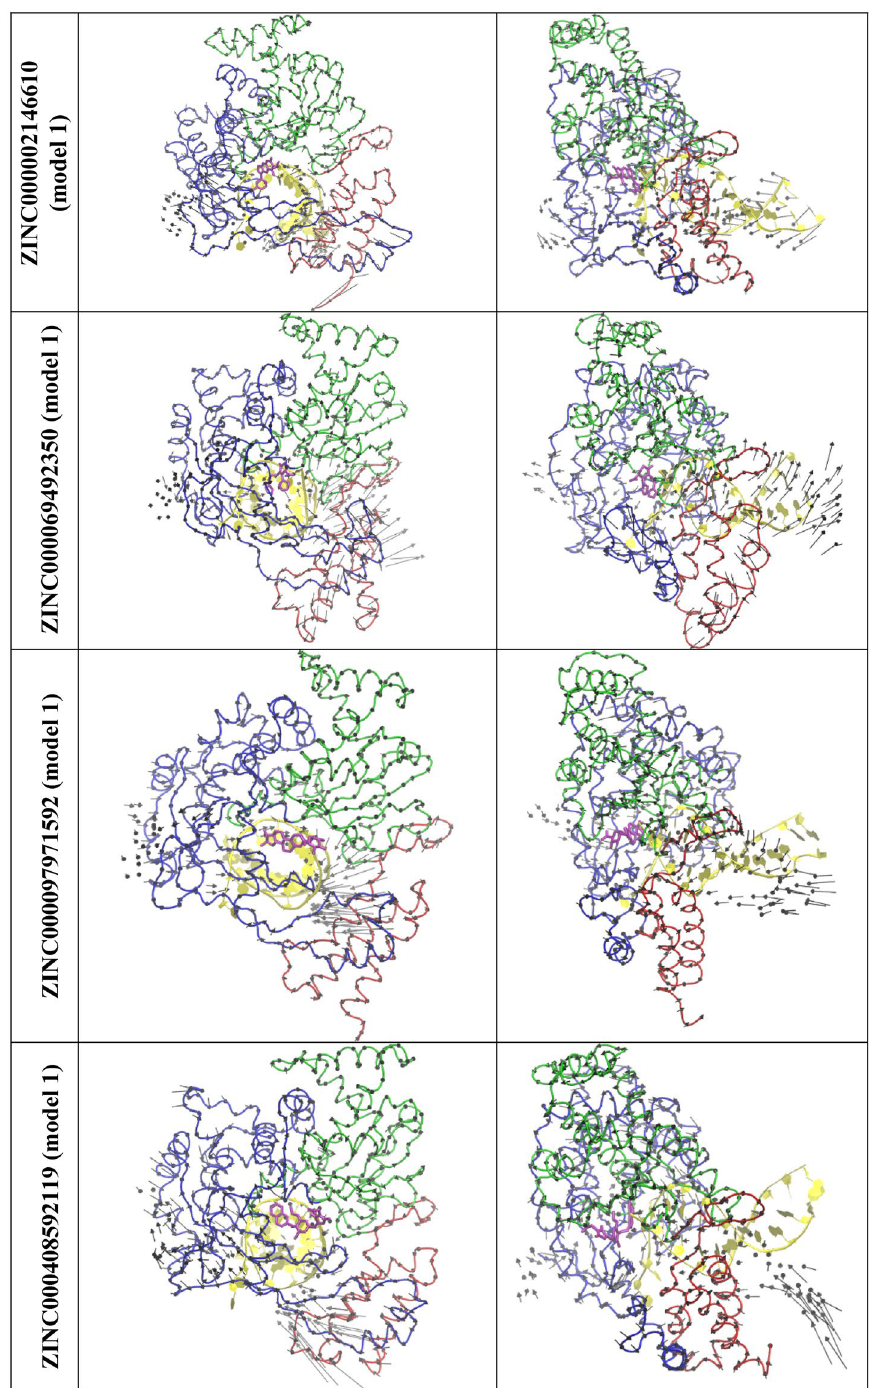
Figure 9. The top view (left) and the side view (right) of a selected normal mode from the top 4 ZINC systems that is most similar to the mode 1 of RTP system. RNA (yellow) and, Thumb domain (Red), Palm domain (Green), Finger domain (Blue) of RdRp is shown